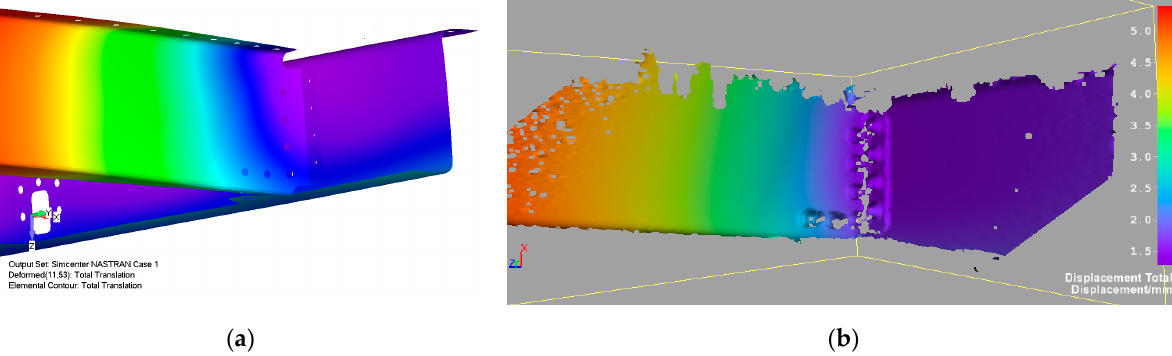
Figure 22. Comparison of total displacement contour map calculated using FE model (a) and measured using DIC system (b) before beginning of fatigue loading for LL level.